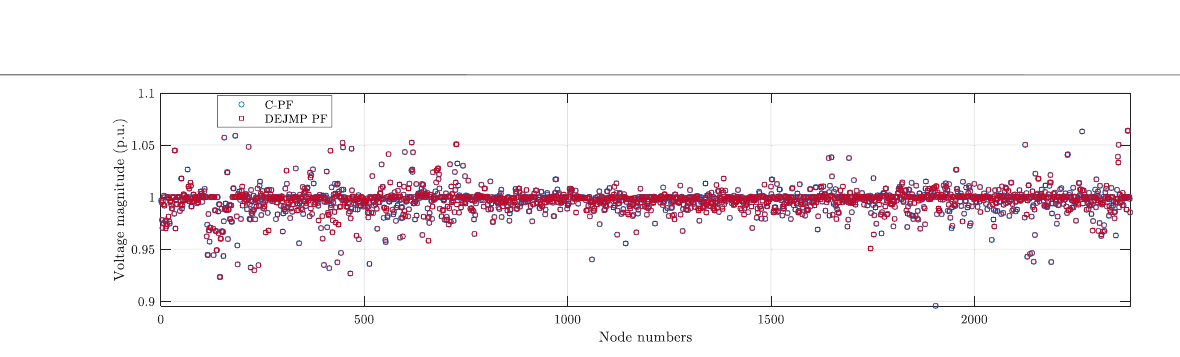
Frontiers in Energy Research |